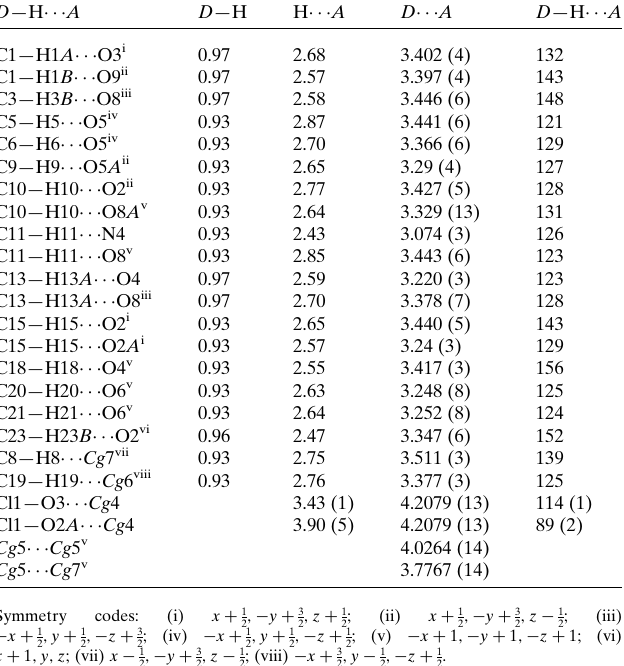
Table 2 Hydrogen-bond geometry and (cid:2) – (cid:2) stacking interactions (A˚ , (cid:4) ). Cg 4, Cg 5, Cg 6 and Cg 7 are the centroids of the N2/C4–C7/C12, N3/C14–C17/ C22, C7–C12 and C17–C22 rings, respectively.